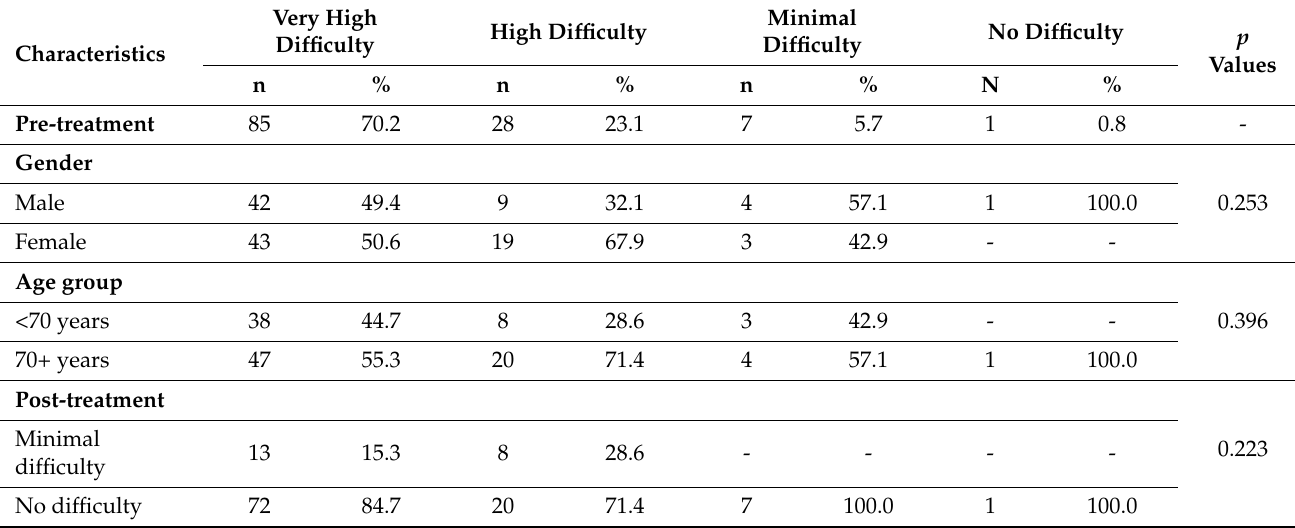
Table 2. The percentage distribution of patients with reading difficulties of a newspaper text according to pre- and post-treatment study group characteristics.